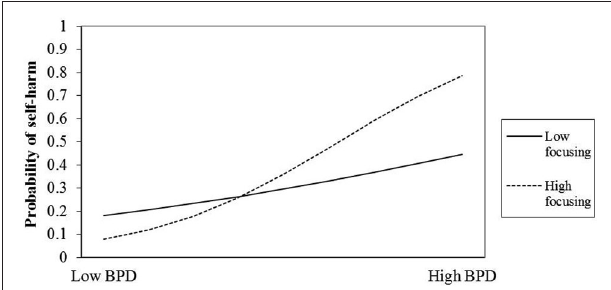
FIGURE 1 | Interaction of BPD and Focusing ability on likelihood of prior